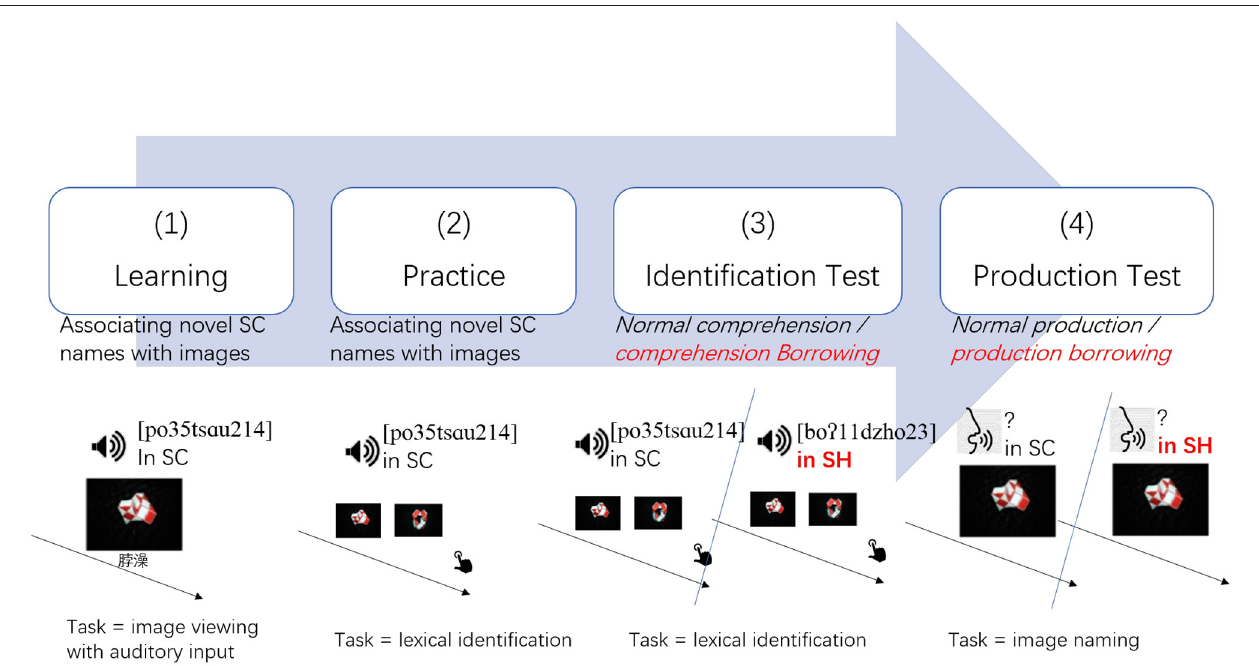
TABLE 2 | Experiment procedure (normal fonts) and the corresponding theoretical implications (bold fonts).